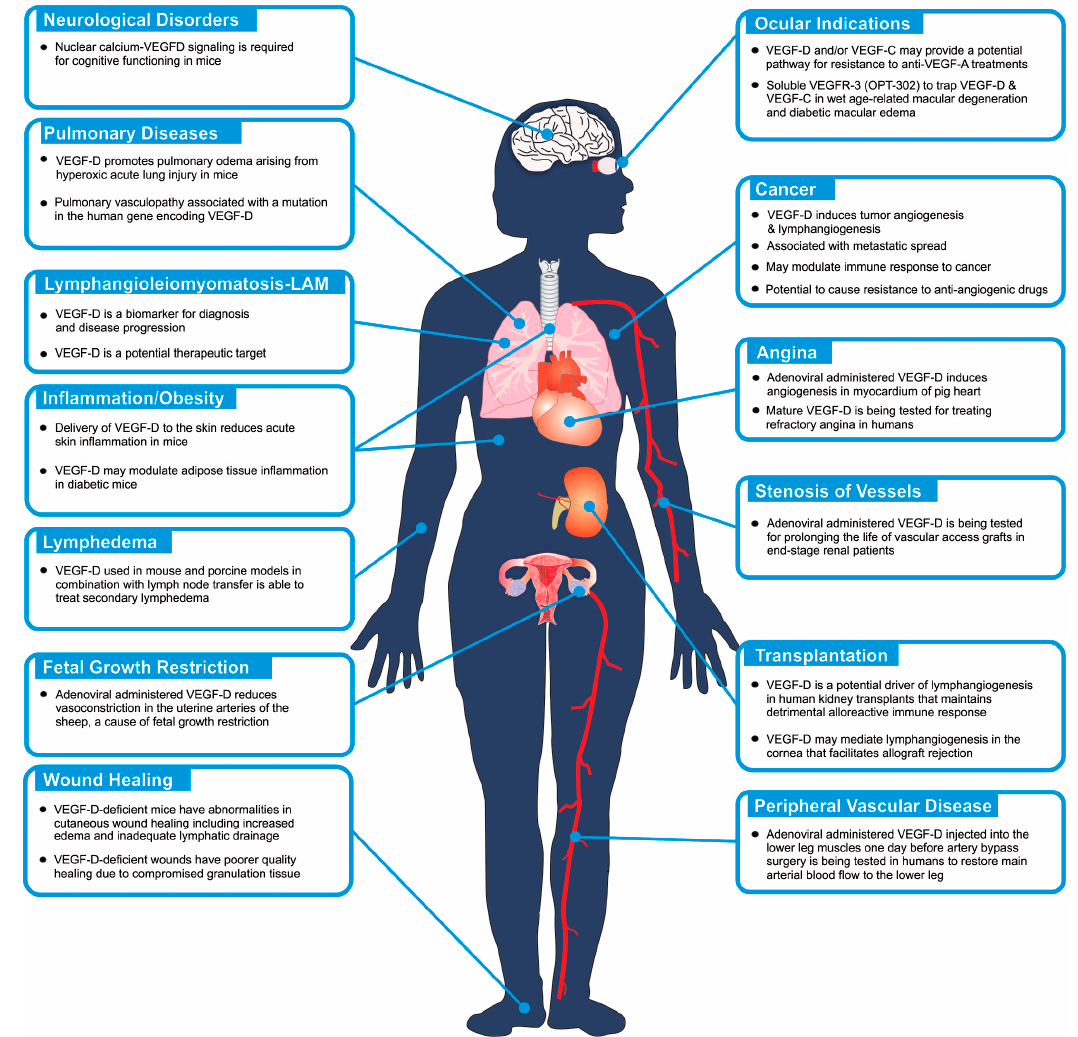
Figure 2. Schematic diagram illustrating areas of the human body that may have VEGF-D-dependent biological and pathological processes. The diagram highlights those biological processes that have been demonstrated to be involved in human pathology (see text for references), and indicates where VEGF-D signaling has been demonstrated to be relevant based on animal models, or has been used as a target for therapy or as a biomarker of a disease or the progression of a